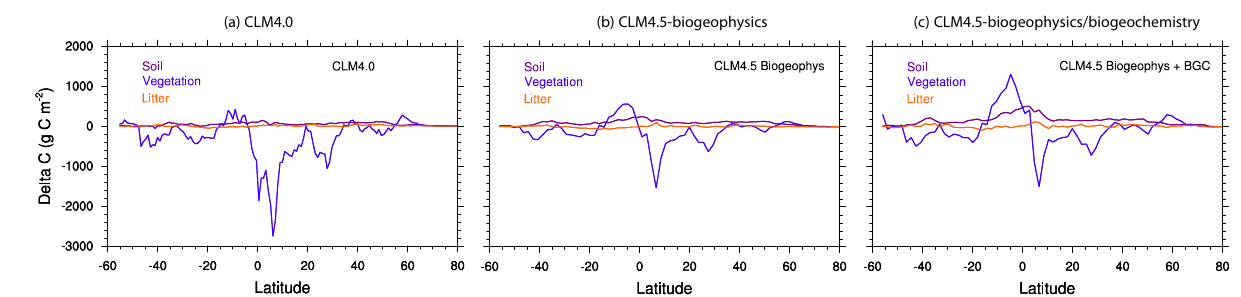
Fig. 14. Change over transient late-20th-century (2005–1955) model simulations in terrestrial C pools, as a function of latitude, for three models: (a) CLM4.0-CN, (b) CLM4.5-biogeophysics, and (c)